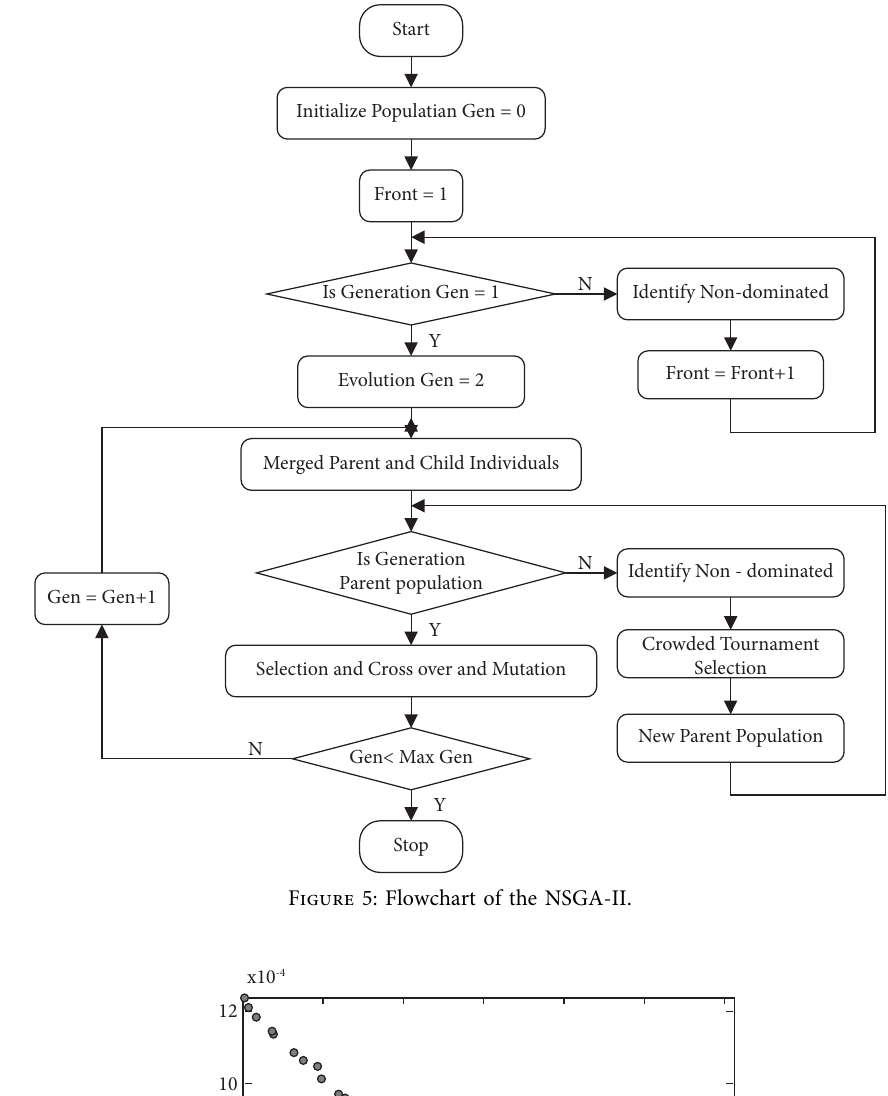
Figure 5: Flowchart of the